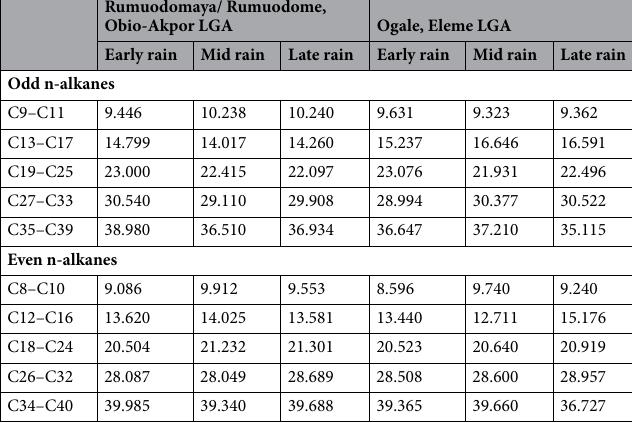
Table 7. Average carbon length (ACL) for TPHs aggregates.